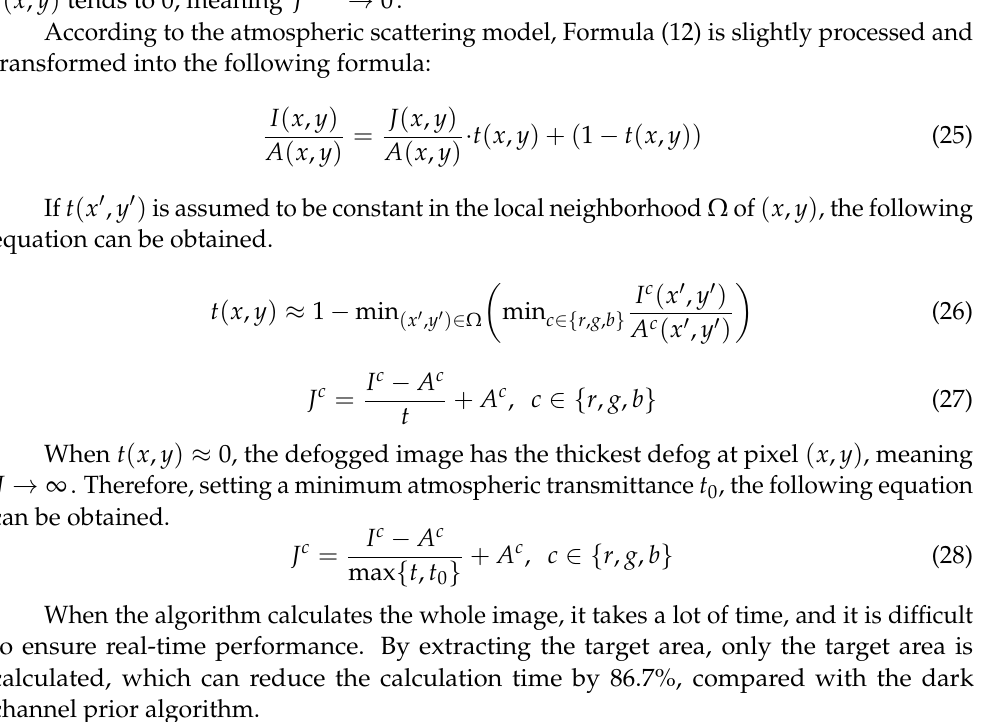
The target area in the foggy image can be extracted through the above method. The target in the target area is the focus of target recognition and detection, so it is enough only to perform the defogging operation in this area. In this way, the amount of calcula-